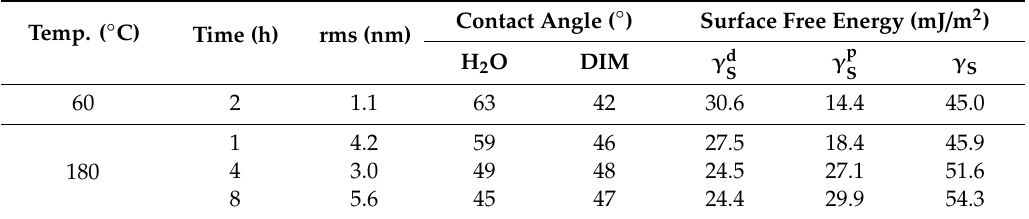
Table 2. Root-mean-square surface roughness, advancing contact angles for water and diiodomethane, and surface free energies of poly(vinyl phenol) prepared in propylene glycol methyl ether acetate (PVPH-P). Temp. ( ◦ C)